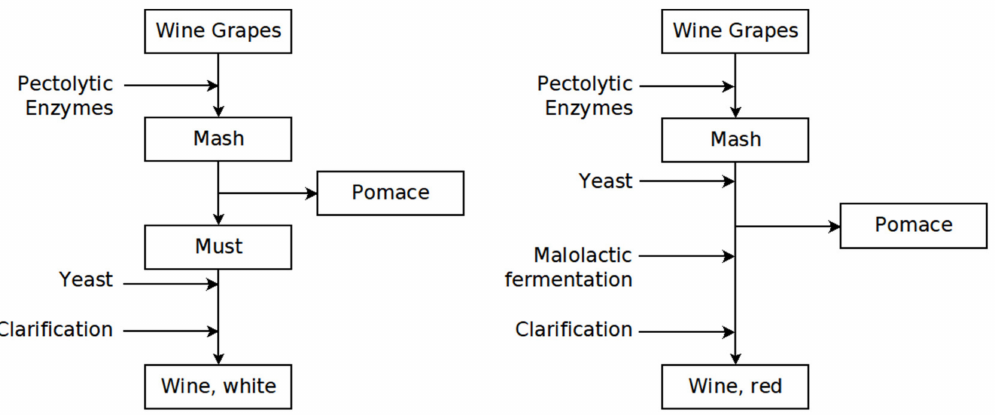
Figure 1. Flowcharts of the processes used in the investigated studies to prepare white wine and red wine (mash fermentation). The red wine production with thermovinification was analogous to the white wine production, with the only difference that the mash was heated to over 60 ◦ C before